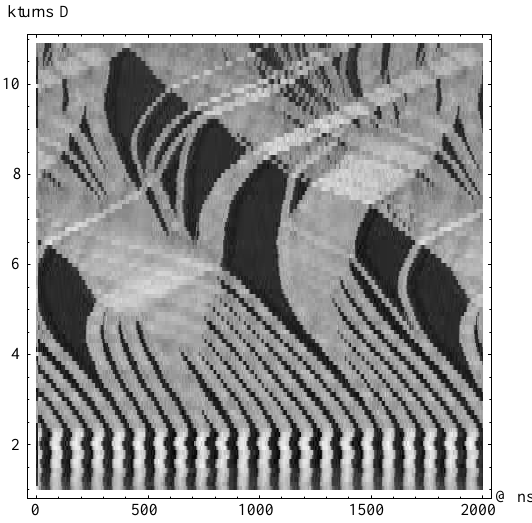
FIG. 12. 2.4 3 10 12 protons, one trace each 100 turns, vertical span 16.7 ms, V rf (cid:1) 0.55 kV.